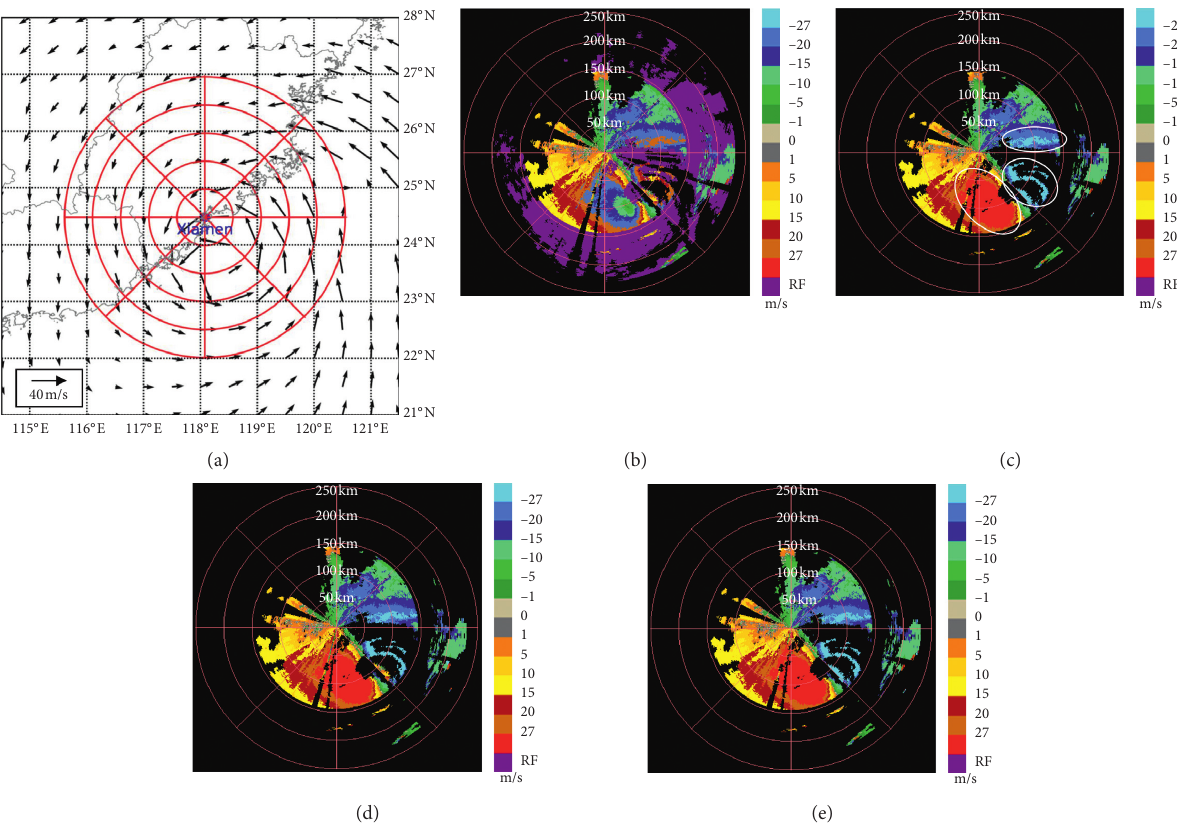
Figure 7: (a) The vector wind fields from the ERA-Interim at 900hPa at 15:00 UTC on September 14, 2016. The radial velocity field of 0.5 ° elevation observed by Xiamen radar at 14:59 UTC, September 14, 2016: (b) raw velocity field, (c) manually dealiased velocity field, (d) dealiased velocity field by the CIDA algorithm, and (e) dealiased velocity field by the MVDR algorithm. The manual dealiased results are marked by white ellipses in (c).